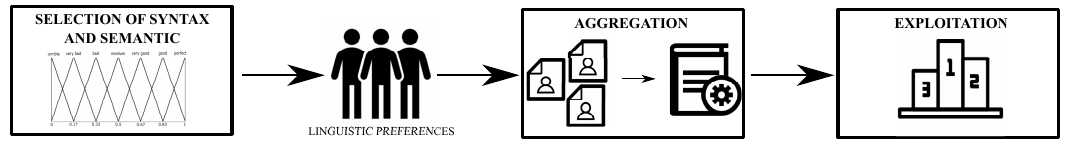
Figure 2. LDM resolution